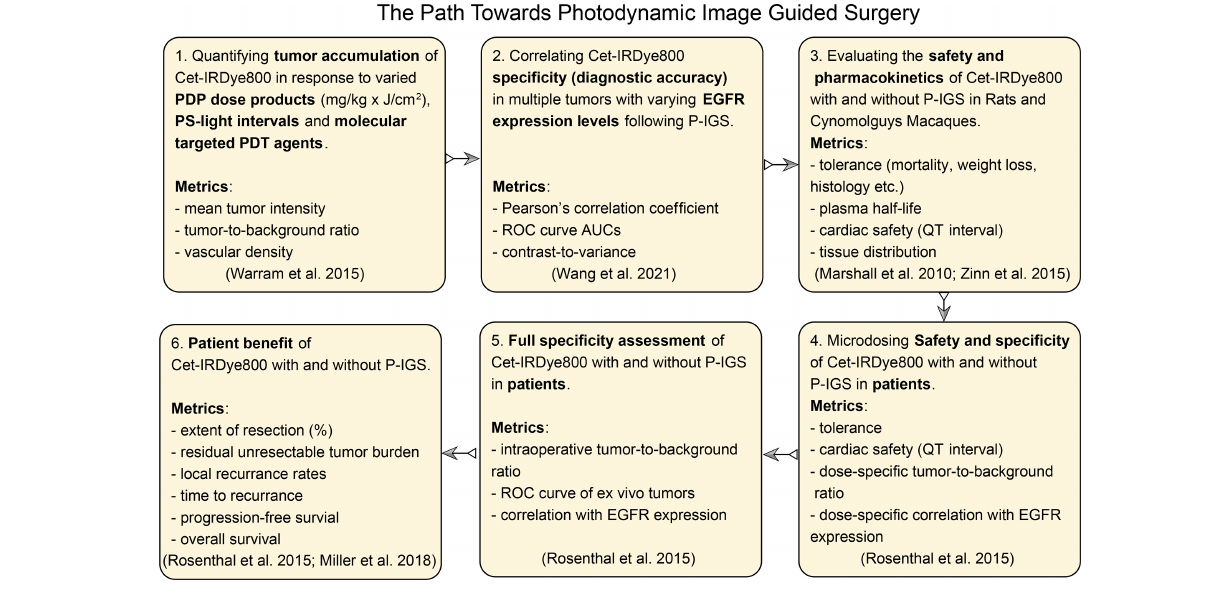
FIGURE 7 | The path towards photodynamic image-guided surgery proposed, including anticipated necessary metrics, in accordance with the published path of clinical translation of Cet-IRDye800 and related IGS probes (10, 30, 44 –